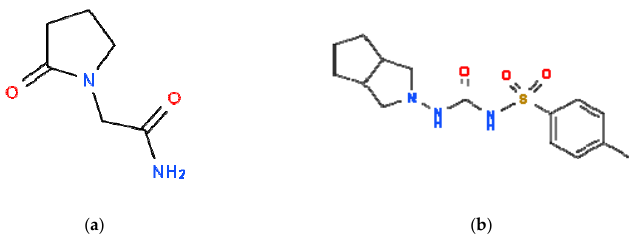
Figure 2. Chemical structure of ( a ) piracetam (PIR) and ( b ) gliclazide (GLZ). The structures were downloaded from